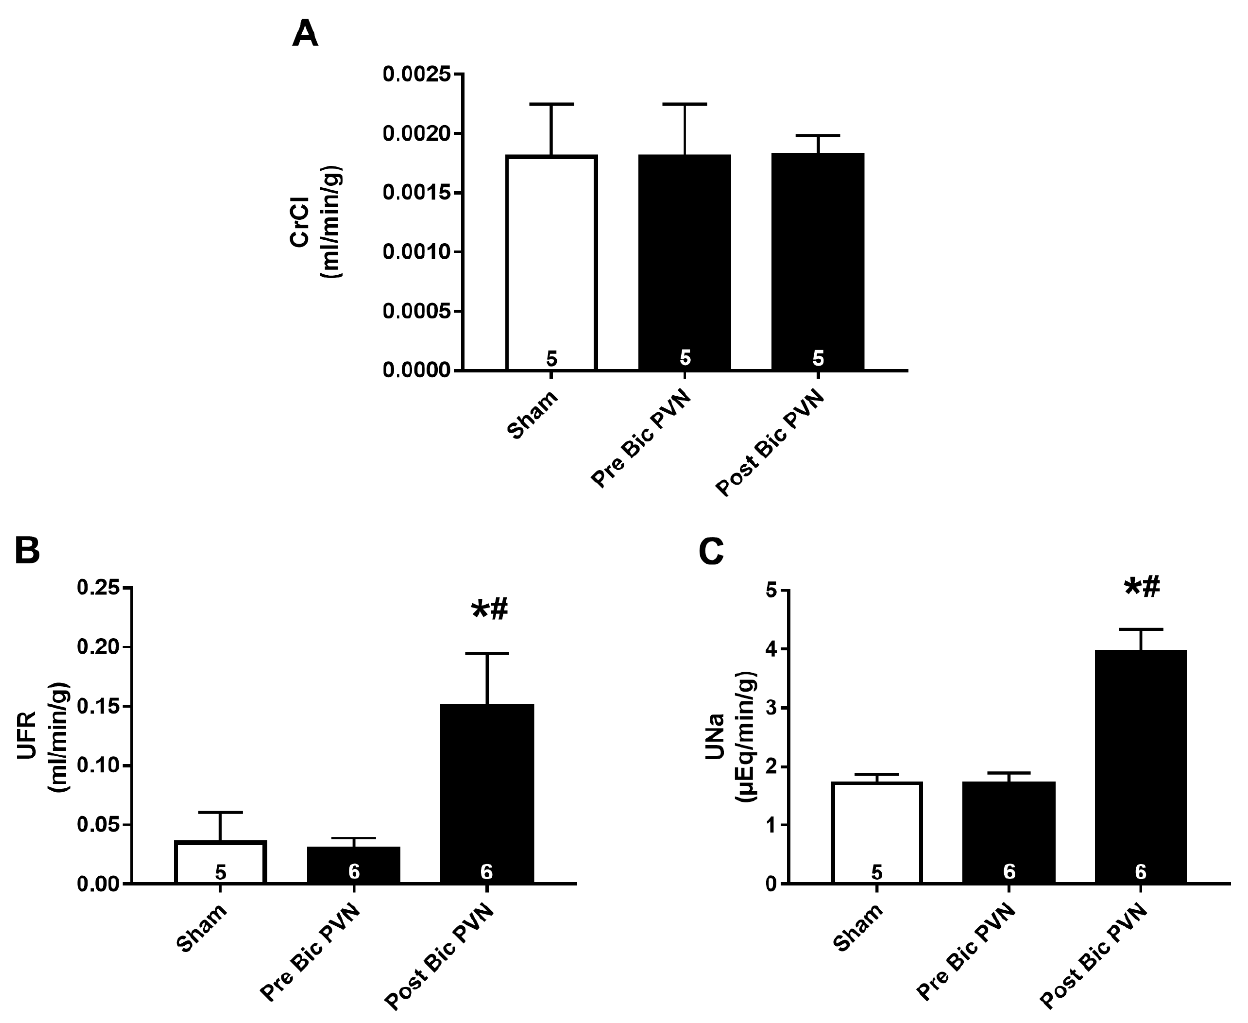
Figure 2. Effect of bicuculline on the paraventricular nucleus of the hypothalamus (Bic PVN) on renal function. ( A ) Creatinine clearance (CrCl) of rats in the sham, pre-Bic PVN, and post-Bic PVN groups. ( B ) White bar represents the urinary flow rate (UFR) of rats in the sham group during the experiment, and black bars represent the UFR of rats in the Bic PVN group before and after Bic injection. ( C ) White bar represents the urinary sodium rate (UNa) of rats in the sham group during the experiment, and black bars represent the UFR of rats in the Bic PVN group before and after Bic injection. The number of rats is shown inside the bars. * p < 0.001 compared to sham. # p < 0.001 compared to pre-Bic PVN. One-way analysis of variance for multiple comparisons followed by Tukey’s